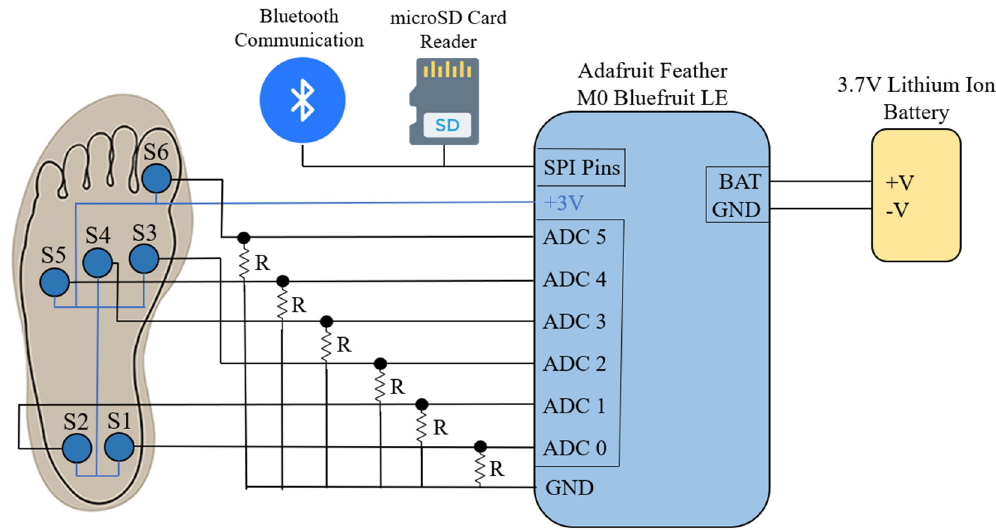
Figure 1. Schematic of the proposed pressure sensing system.